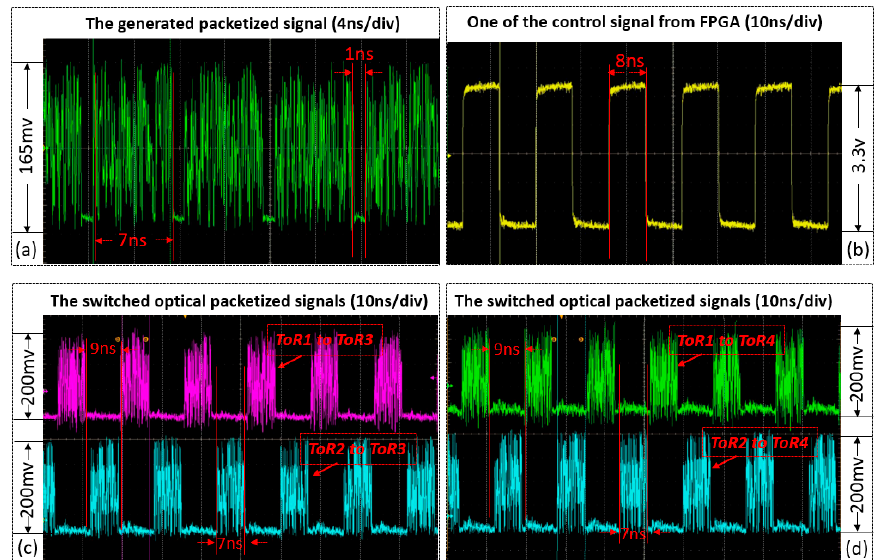
Figure 9. ( a ) The electrical signal generated by the pattern generator; ( b ) the control signal from the FPGA; ( c ) the switched optical packetized signals from ToR1 to ToR3 and ToR2 to ToR3; ( d ) the switched optical packetized signals from ToR1 to ToR4 and ToR2 to ToR4.